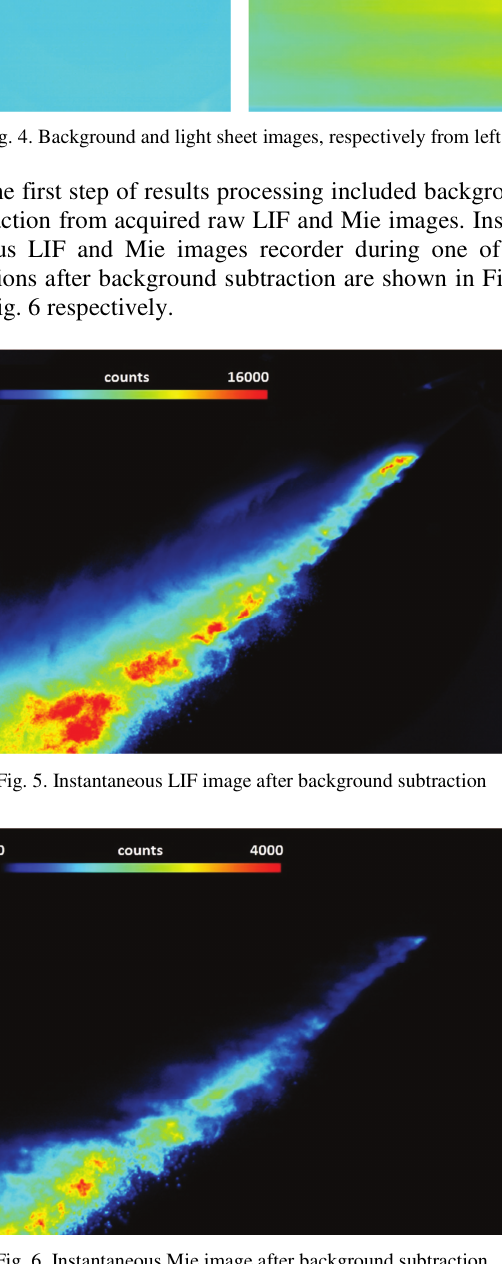
Fig. 6. Instantaneous Mie image after background